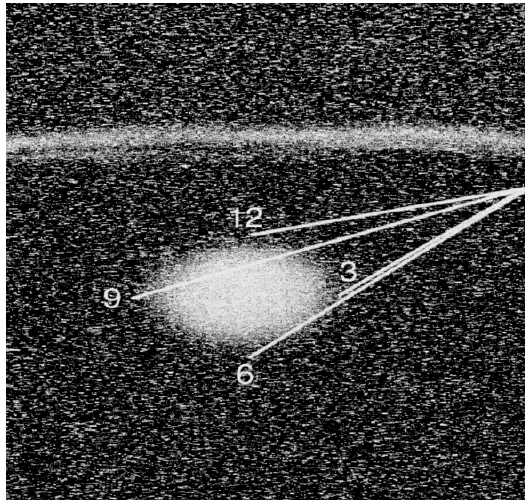
Figure 9. The diagram illustrates the technique for SLNB with sonographic guidance. Using one needle, peritumoral injections are performed at the three, six, nine and 12 o’clock positions.